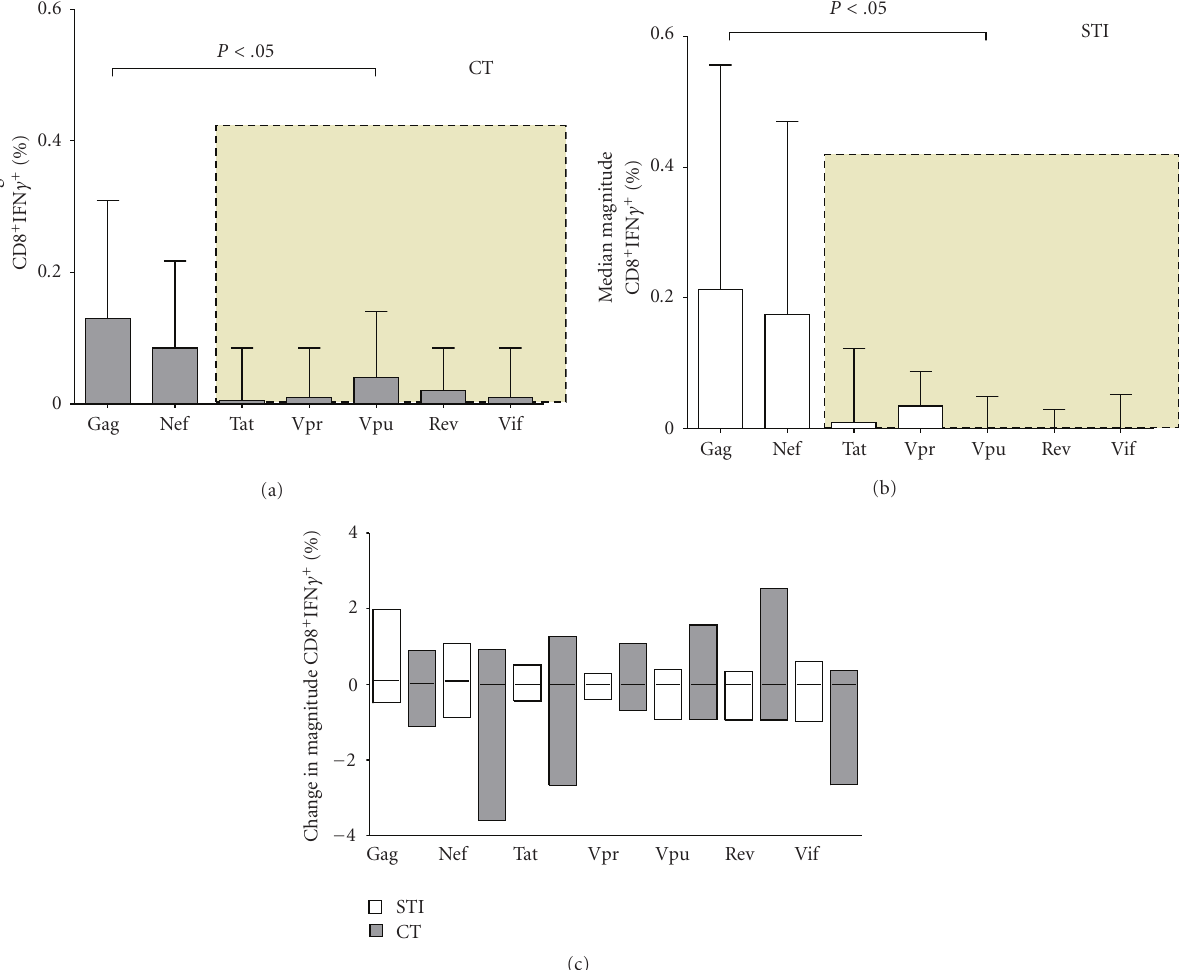
Figure 3: Magnitudes of CD8 + T-cell responses associated with STI. This figure compares the median magnitudes of HIV-induced CD8 + T-cell IFN- γ responses in (a) STI and CT participants after one cycle of STI or matching time on CT. Bars represent medians, while error bars represent interquartile ranges. The shaded areas represent HIV proteins that induced significantly lower magnitudes of CD8 + IFN- γ + than Gag or Nef. (c) illustrates the median change in magnitudes of HIV-specific IFN- γ responses after one cycle of STI or matching time on CT. Horizontal bars represent